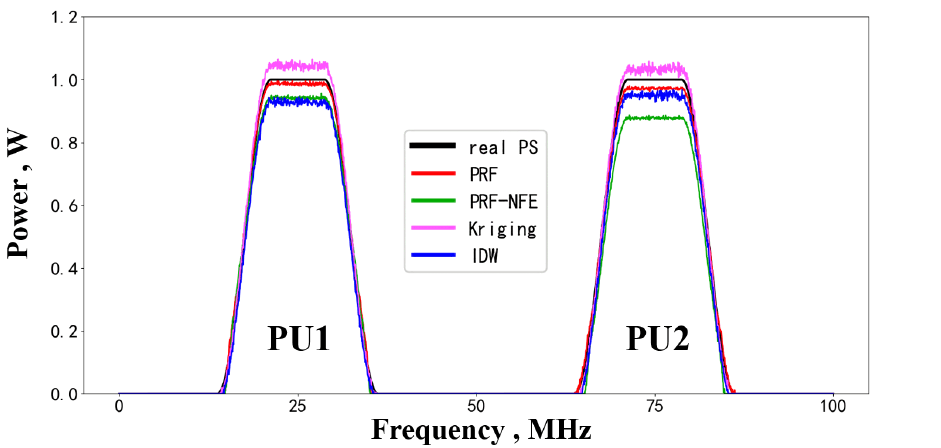
Figure 12. The power spectrum reconstruction results for